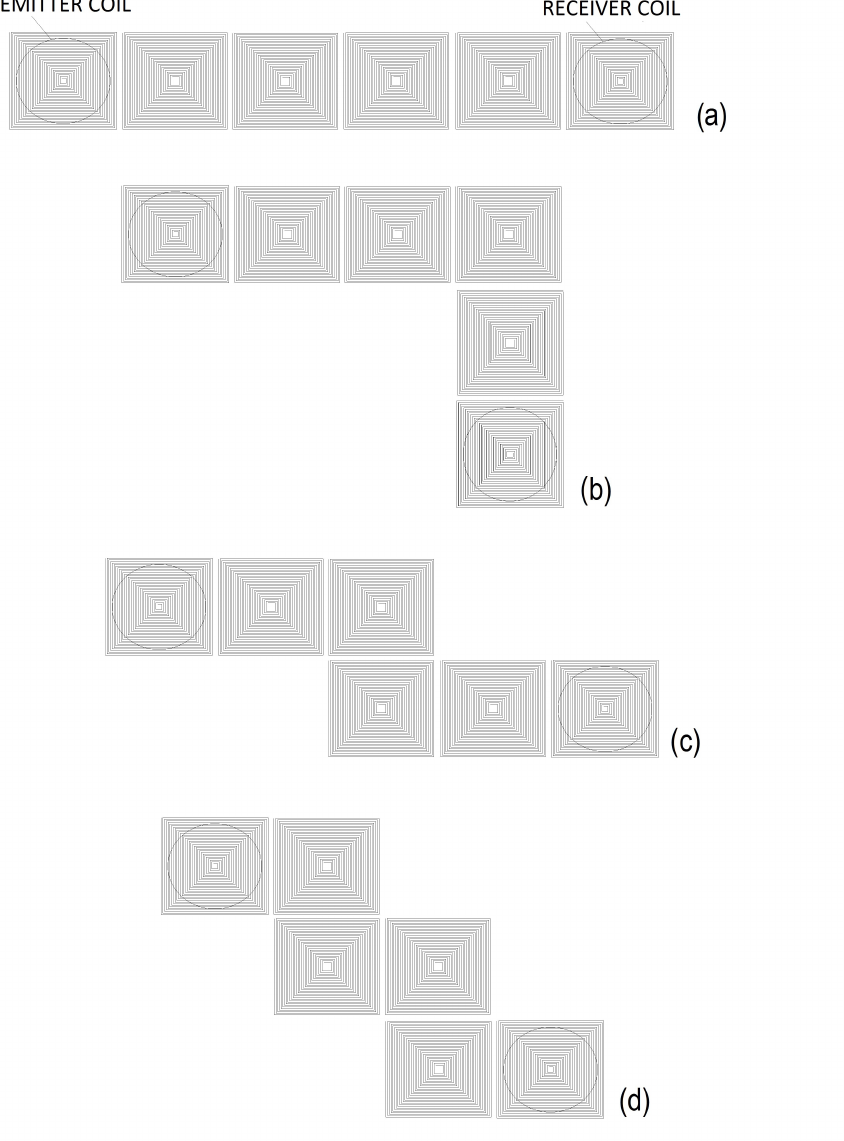
( a ) I-arrangement; ( b )